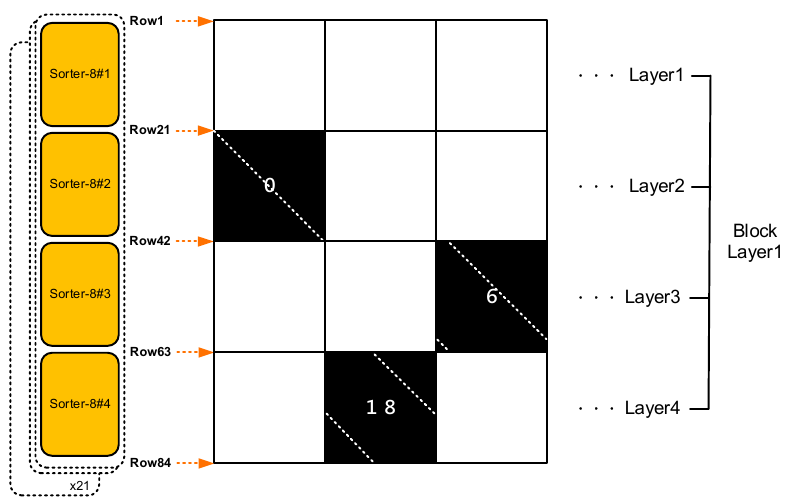
Figure 23. Reconfigurable sorter configuration in IEEE 802.15.3c R = 1/2.